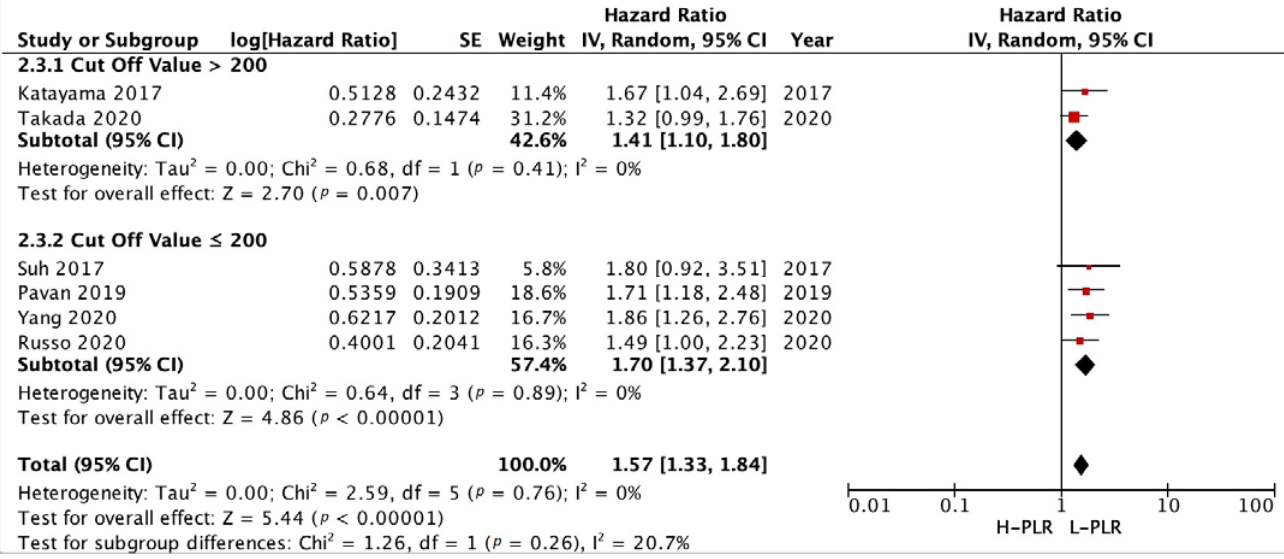
Figure 10. Forest plot cut-off value subgroup analysis of H-PLR versus L-PLR to PFS in patients treated with immunotherapy. Red dots represent study weights; the bivalve represent the overall effect.